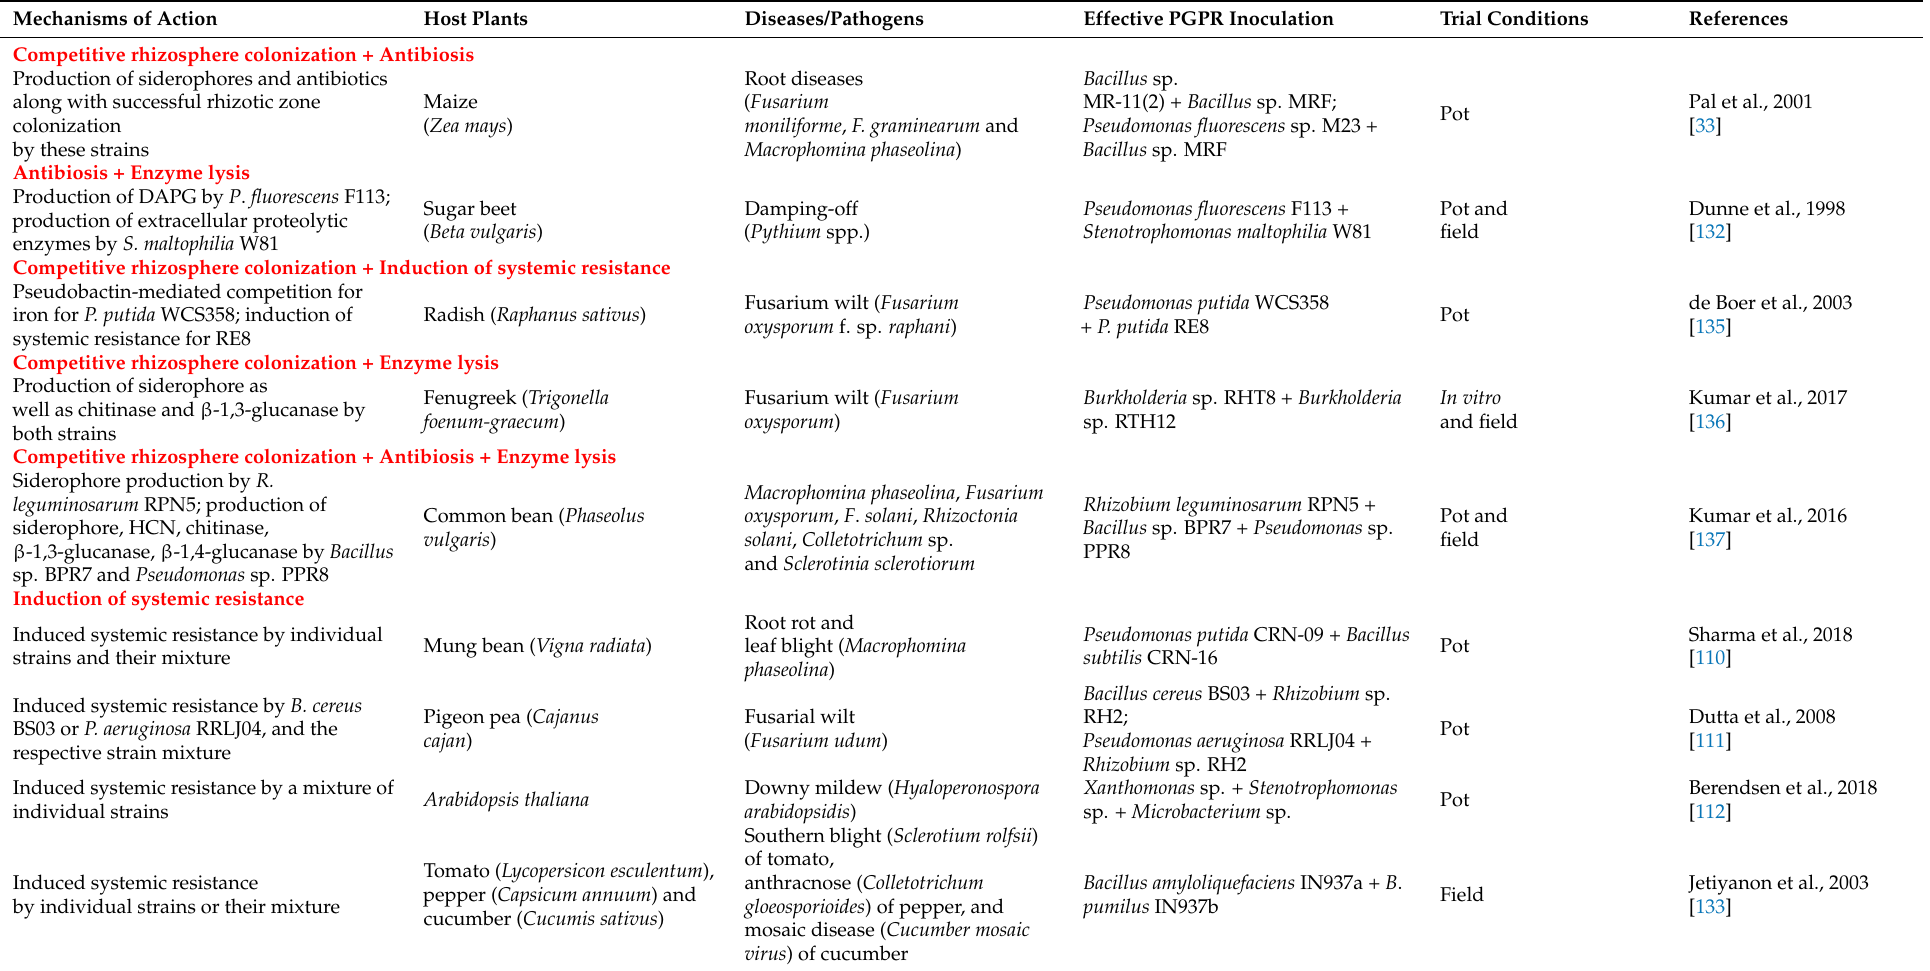
Table 1. PGPR mixtures effective against different plant pathogens along with their mechanisms of action with example case